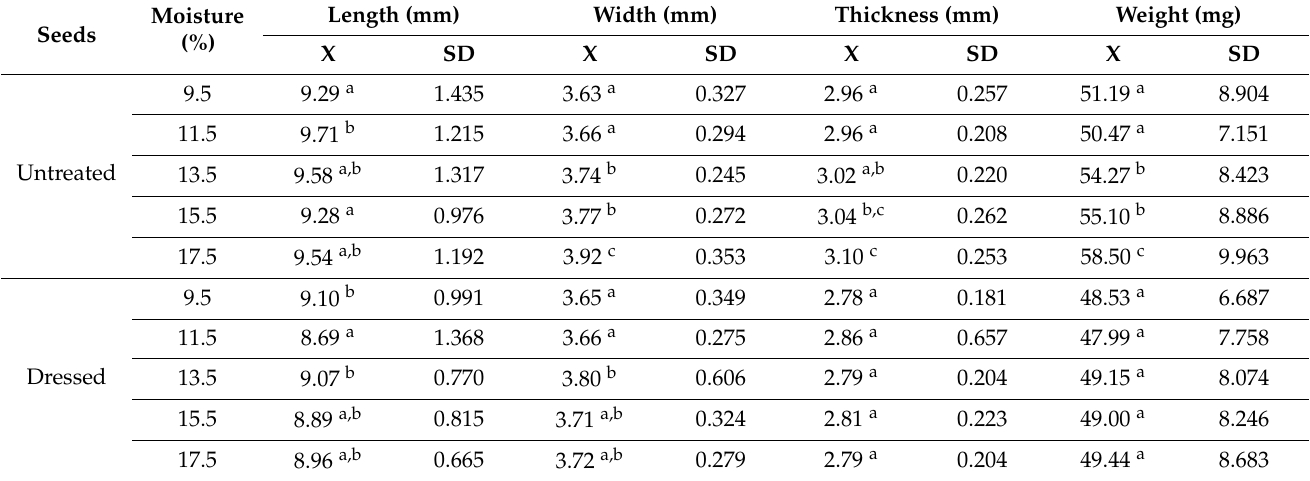
Table 2. The statistical parameters of the physical characteristics of winter barley seeds.